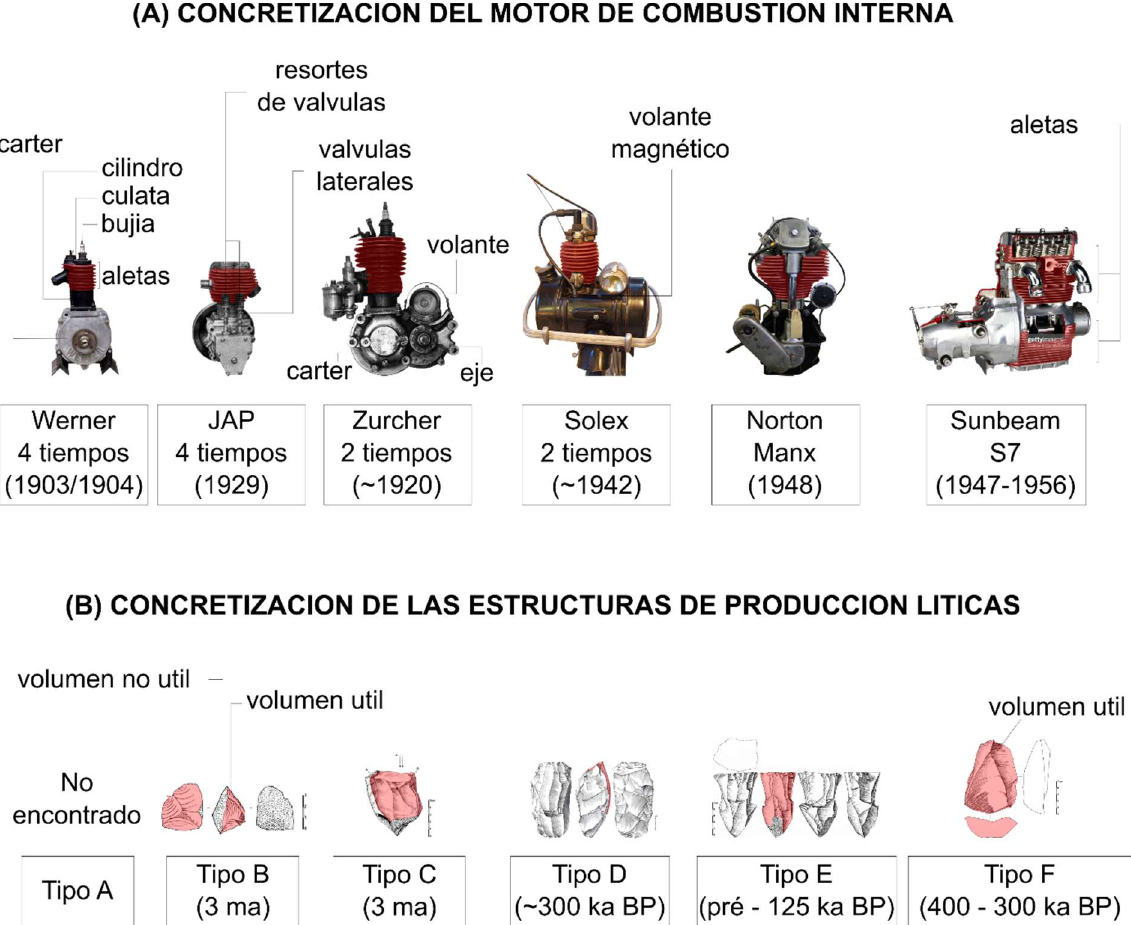
Figura 7. Ejemplo de concretización de los objetos técnicos. (A) Concretización del motor de combustión interna (elaborado a partir de Simondon 2012: 20-26). El área de color rojo en cada motor corresponde a las aletas que, con el tiempo, comienzan a ganar más espacio en la estructura del motor. En otras palabras, las aletas comienzan a integrarse de manera más efectiva con los demás elementos. (B) Concretización de estructuras de producción lítica (elaborado a partir de Boëda 2013: 60-72), utilizando núcleos arqueológicos de diferentes sitios arqueológicos. El área coloreada en rojo en cada núcleo corresponde a los volúmenes útiles ( sensu Boëda 2013: 89) que, con el tiempo, también comienzan a ganar más espacio en la estructura del núcleo. Se definen seis estadios técnicos principales (A-F), en los que se pueden